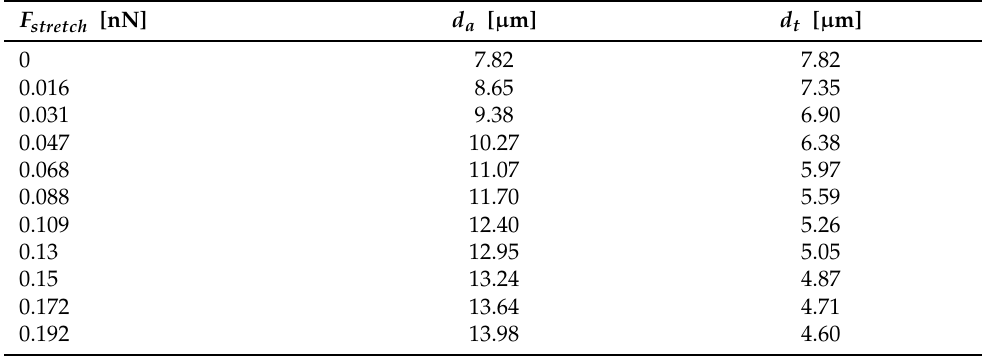
Table A6. Final axial d a and transversal d t diameters in optical tweezers stretching experiment at volume fraction φ =